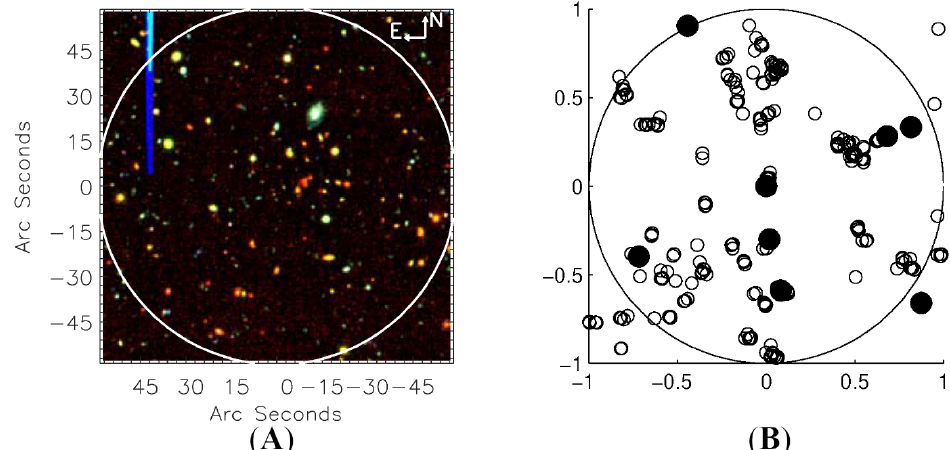
Figure 8. ( A ) is the image of the central 1 Mpc region of galaxy clusters spanning the redshift range of detections in [40]. Adapted with permissions from Ref. [40]. Copyright 2006 Oxford Journals. ( B ) is the pattern by Monte Carlo simulations with the UZ ansatz. Full circles are the seed node positions of the Markov